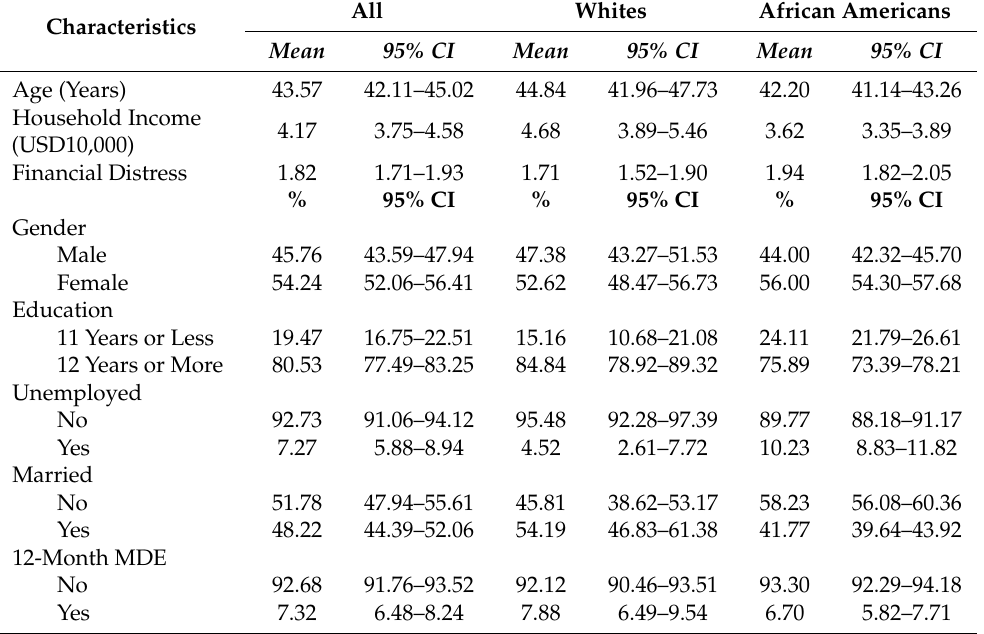
Table 1. Descriptive statistics in the pooled